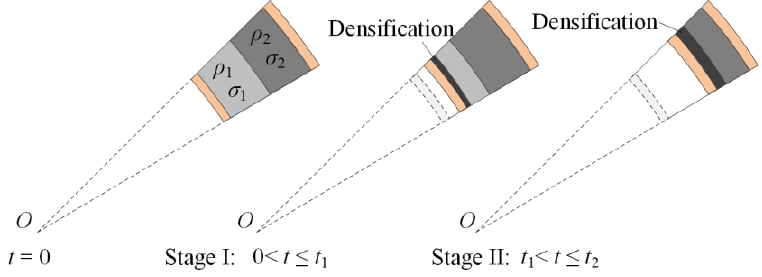
Figure 3. Response process of a cylinder with a positive-gradient core.